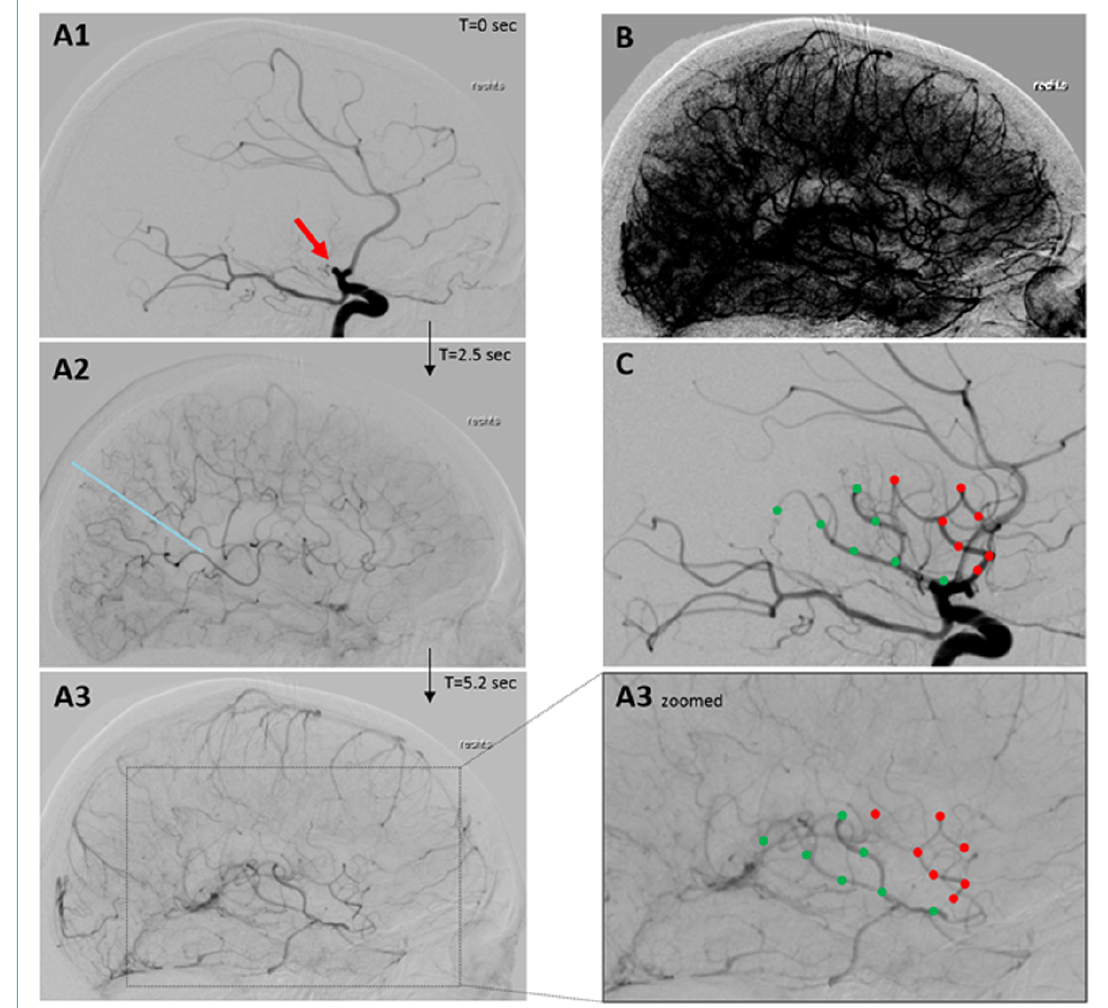
Figure 2: Leptomeningeal collateral flow in occlusion of the proximal middle cerebral artery as seen in conventional angiography (sagittal plane). (A1–A3) : serial images after contrast agent application into the internal carotid artery showing proximal middle cerebral artery occlu- sion (red arrow in A1) with subsequent filling of leptomeningeal collaterals 2.5 sec thereafter fed by the anterior (above and right of blue line in A2) and posterior circulation. After 5.3 sec retrograde collateral flow filled the superior (red dots) and inferior branch (green dots) of the occlud- ed middle cerebral artery (A3 + A3 zoomed). (B) After windowing A3 capillary filling visualised supply of the whole middle cerebral artery terri- tory by collaterals. (C) The same branches filled retrogradely by collaterals in A3 are filled anterogradely after reperfusion of the occlusion. (Pictures: Stroke Centre